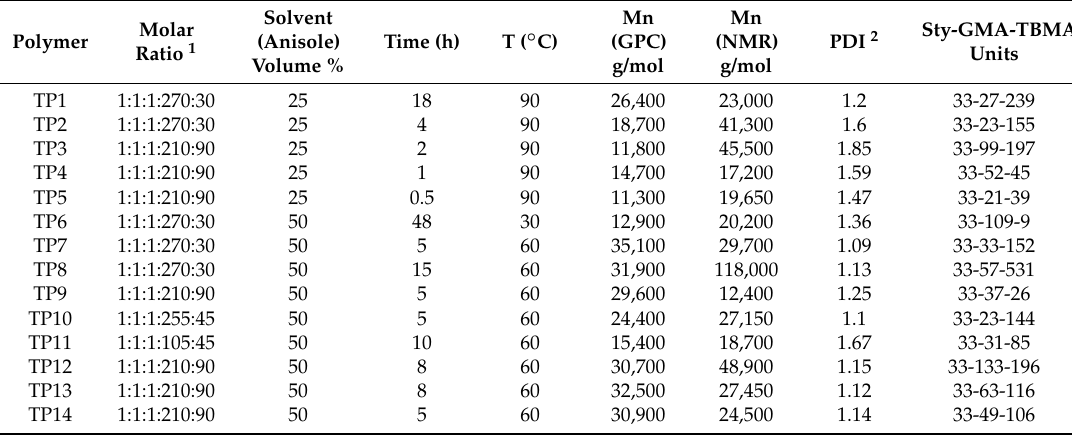
Figure 2. 1 H-NMR (CDCl 3 -d solvent) of macroinitiator PS1 ( a ), terpolymer TP6 ( b ) and terpolymer TP8 ( c ). Table 2. Summary of ATRP chain extension reactions performed using PS1 as macroinitiator and average numeral molecular weight